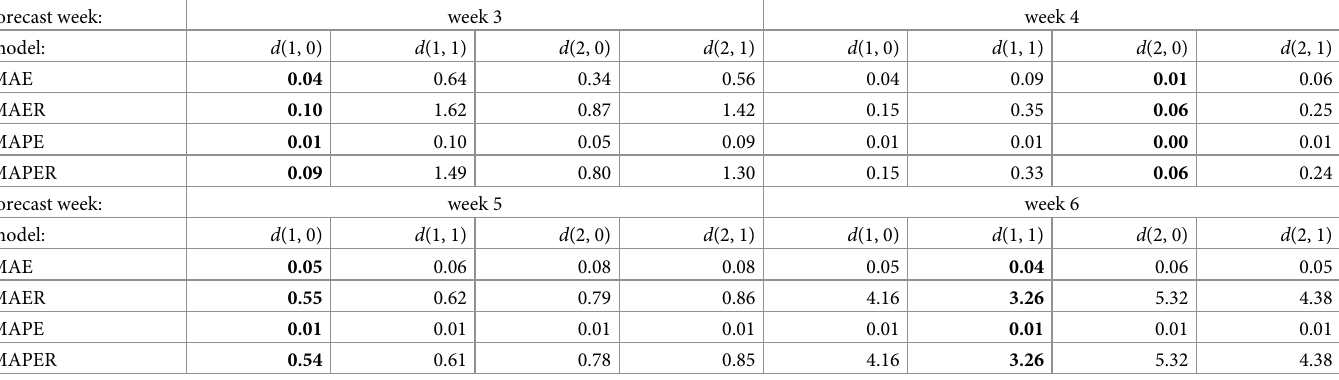
Table 2. Mean Absolute Error (MAE), Mean Absolute Percentage Error (MAPE) along with their relative versions with respect to the Random Walk model (MAER and MAPER, respectively) for models d ( i , j ) over different training samples and forecast periods. forecast week: